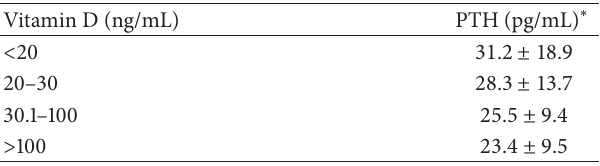
Table 3: Parathyroid hormone concentrations according to vitamin D range. Values of PTH are presented as mean ± standard